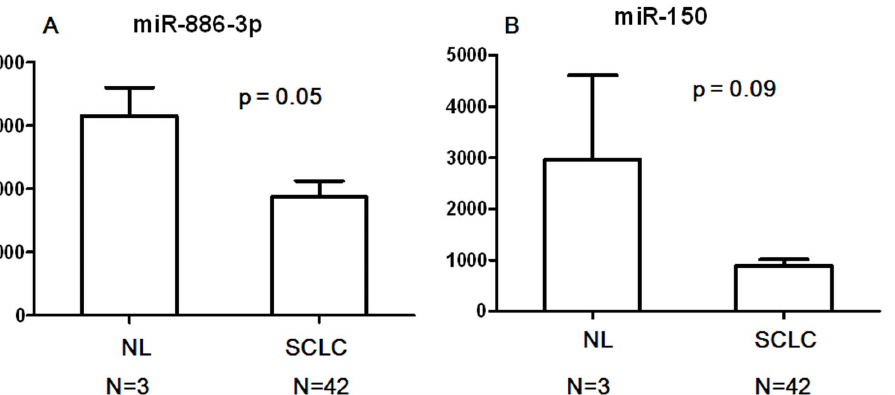
Figure 1. Comparison of expression levels of miR-886-3p and miR-150 between SCLC tumors and normal lung tissues (NL).